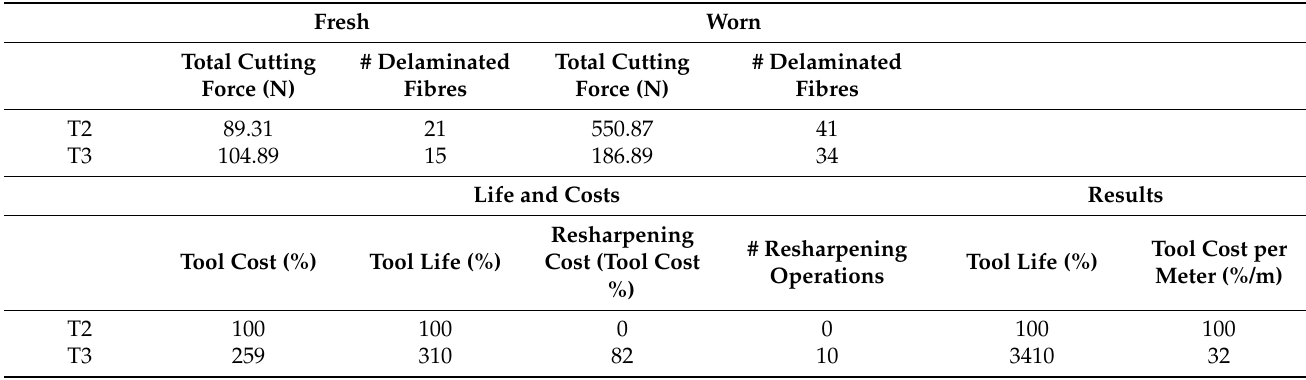
Table 5. Summary table: tool wear, tool life and tool cost (#: number).